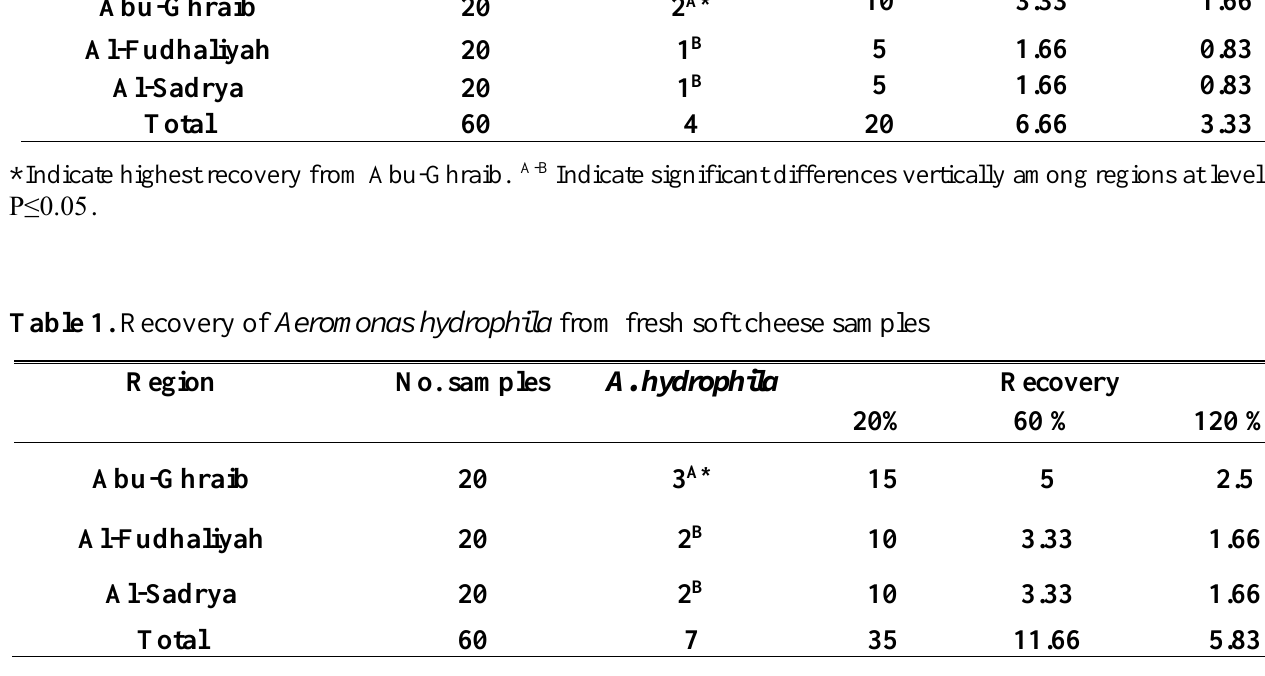
Table 1. Recovery of Aeromonas hydrophila from raw milk samples